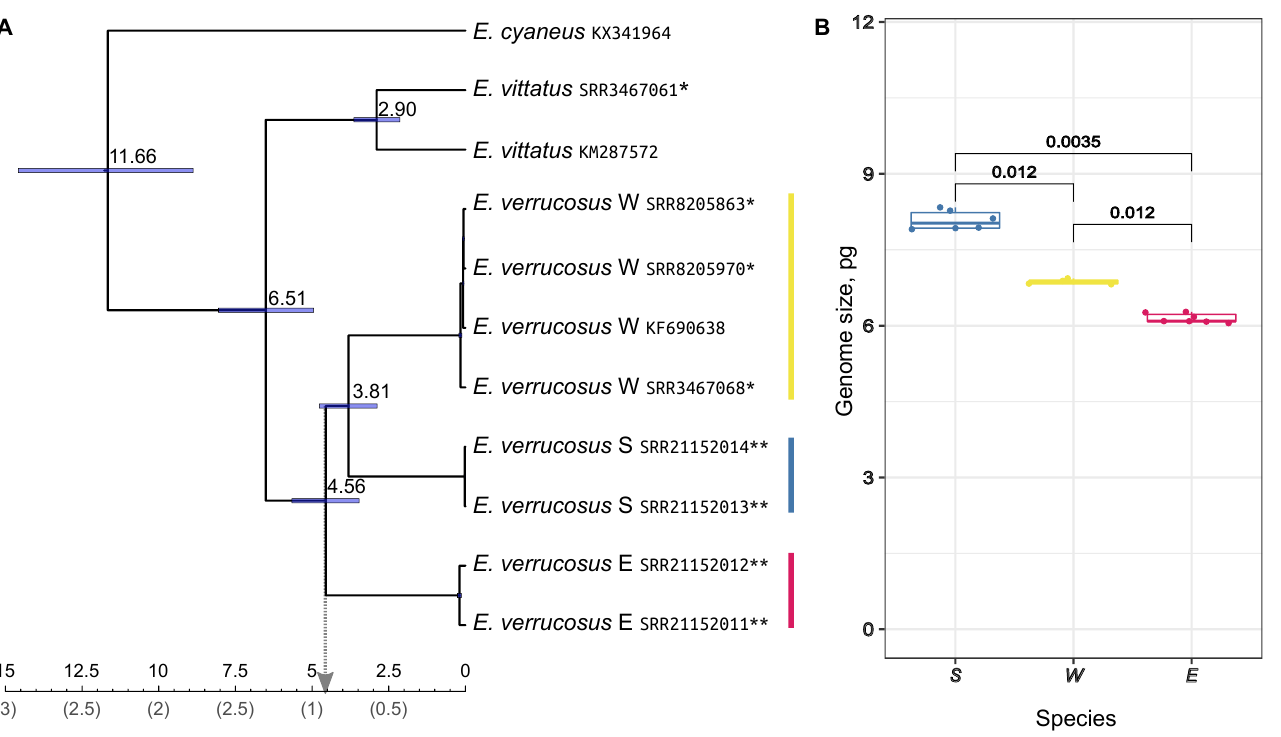
Figure 2. Phylogenetic relationship and genome sizes of E. verrucosus species. ( A ) A calibrated Bayesian phylogeny of three Eulimnogammarus morphospecies based on the sequences of 15 mito- chondrial genes. Calibration (the upper scale) was based on the general substitution rate of 0.01773 in COI established for gammaroid amphipods [73]. The node bars show the 95% highest posterior density (HPD) intervals. The lower scale shows five-fold lower numbers based on the suggestion of elevated evolution rate in Baikal amphipods [37,39]. All posterior probability values were equal to 1 except for the E. verrucosus W SRR8205863 and SRR8205970. Single asterisks mark published transcriptome samples; double asterisks mark transcriptome samples obtained in this work; the samples without asterisks are published complete mitochondrial genomes. See Table S1 for references. ( B ) Genome size assessment for representatives of the three E. verrucosus species. The value in pg was estimated with flow cytometry as the ratio between median intensities of E. verrucosus and Hermetia illucens nuclei fluorescence. The numbers above the brackets represent p -values for the pairwise Wilcoxon rank sum test with Holm correction for multiple comparisons. The number of replicates: n = 4 for W; n = 6 for S and E. Please refer to Table S2 for raw